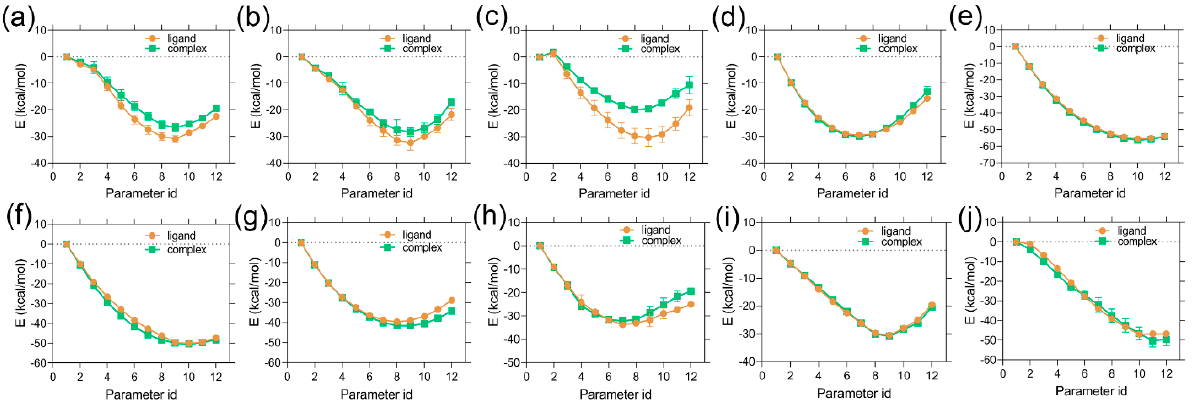
Figure 5. FEP energy convergence plots of ( a ) C36 → C28, ( b ) C36 → C38, ( c ) C36 → C64, ( d ) C36 → C73, ( e ) C36 → C76, ( f ) C36 → C80, ( g ) C36 → C83, ( h ) C70 → C45, ( i ) C36 → C89, and ( j ) C36 → C114 in isolated and complex form. Table 2. Energy terms of alchemical binding energy transformation from state-A to state-B.